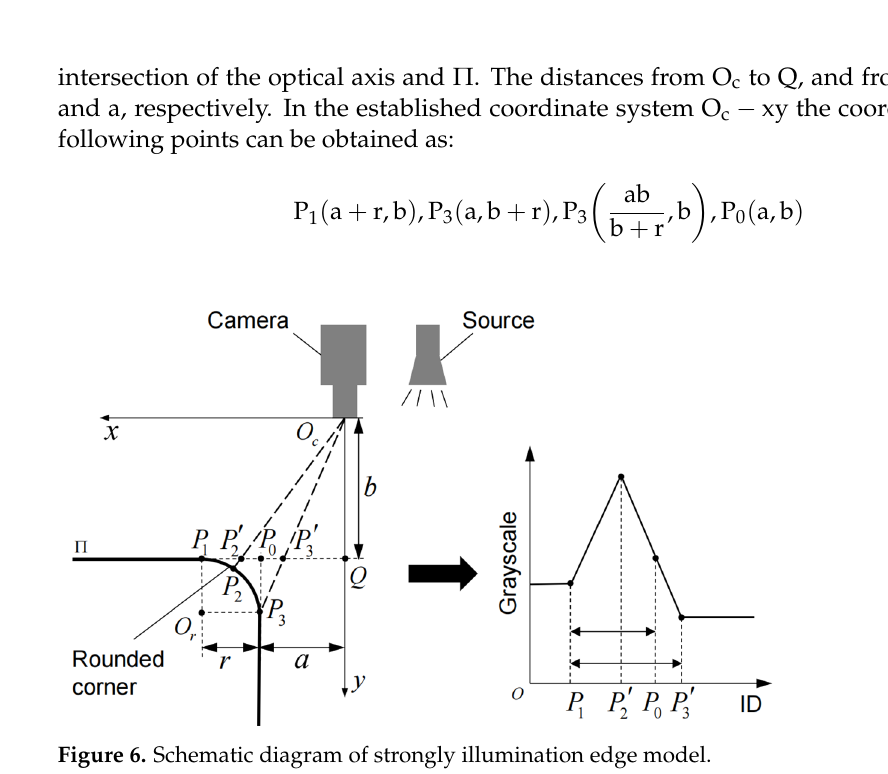
Figure 6. Schematic diagram of strongly illumination edge